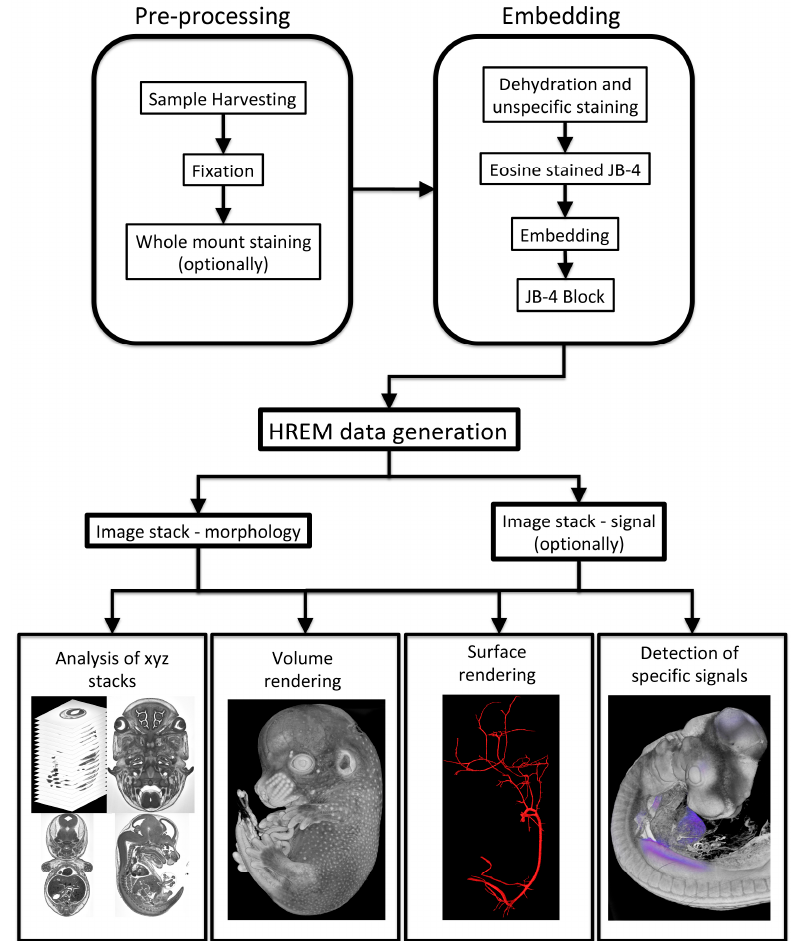
Figure 1. Workflow. The flow chart briefly summarizes the steps of the HREM-workflow from sample harvesting to 3D visualisation and data analysis.